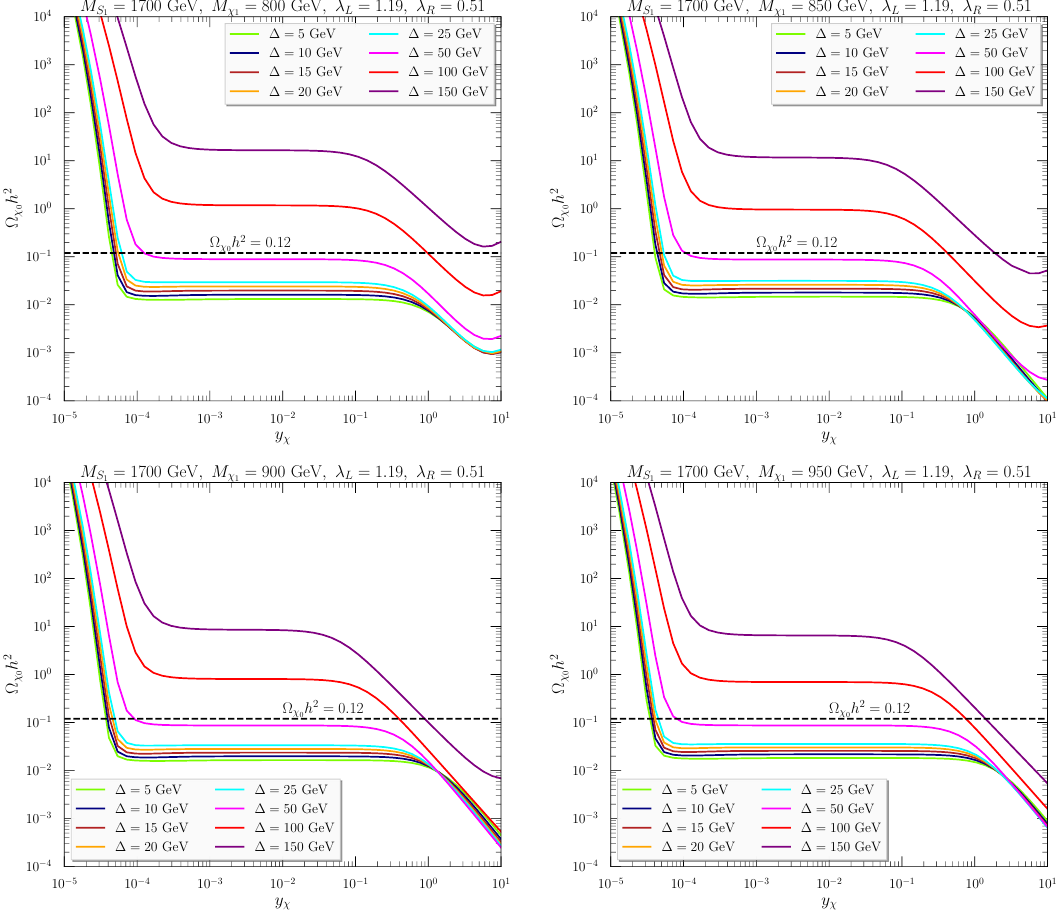
Figure 14 . The DM relic abundance as a function of y χ in BS1 scenarios for M S = 1700 GeV , λ L = 1 1 . 19 and λ R = 0 . 51 . We consider four options for the χ 1 mass consistent with constraints from missing energy searches at the LHC: M χ = 800 GeV (upper left), 850 GeV (upper right), 900 GeV 1 (lower left) and 950 GeV (lower right). The curves in green, navy, sienna, orange, cyan, magenta, red and purple correspond to values of ∆ of 5, 10, 15, 20, 25, 50, 100 and 150 GeV respectively.